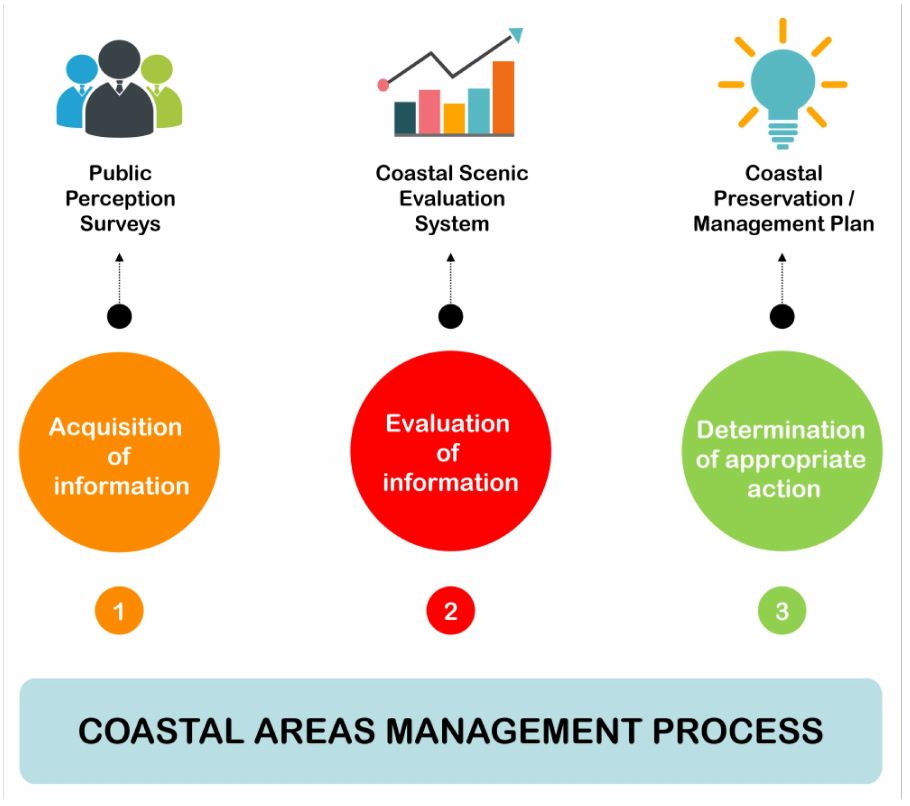
Figure 10. Determination of priorities and appropriate actions through the coastal zone mana gement